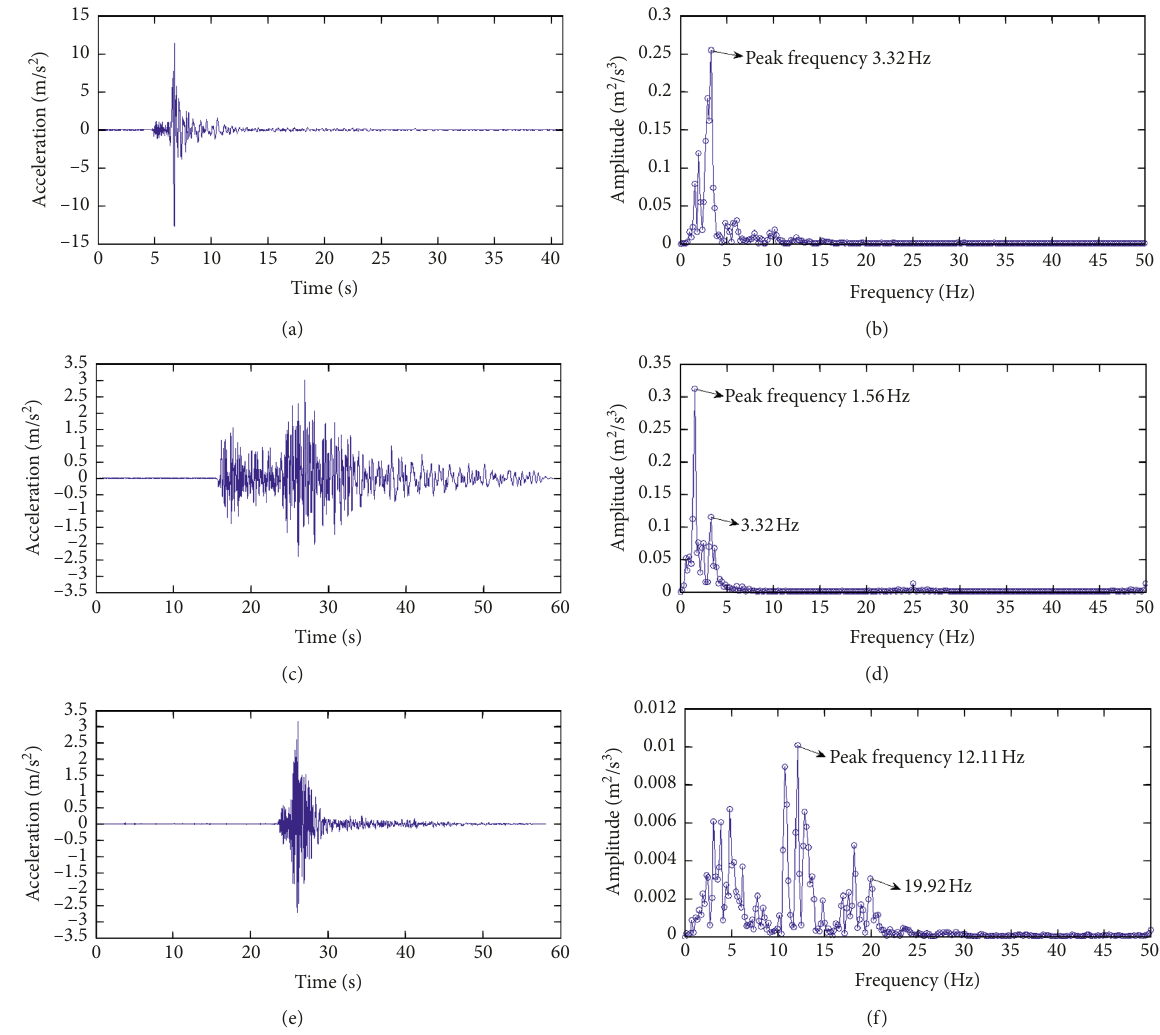
Figure 16: The strong-motion records of channel 9 and the corresponding power spectrums during three major California earthquakes: (a) the strong-motion record of channel 9 during the San Fernando earthquake; (b) the power spectrum of the strong-motion record of channel 9 during the San Fernando earthquake; (c) the strong-motion record of channel 9 during the Chino hill earthquake; (d) the power spectrum of the strong-motion record of channel 9 during the Chino hill earthquake; (e) the strong-motion record of channel 9 during the Newhall earthquake; (f) the power spectrum of the strong-motion record of channel 9 during the Newhall earthquake.